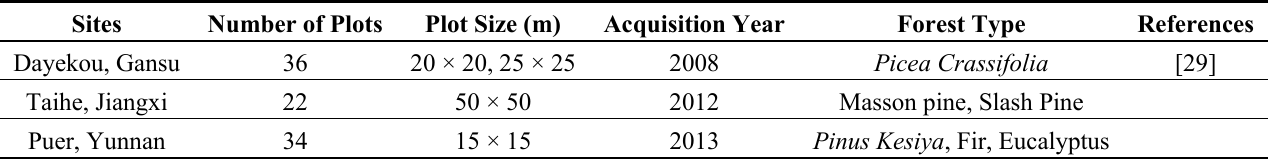
Table 1. The detailed information on three field experiment